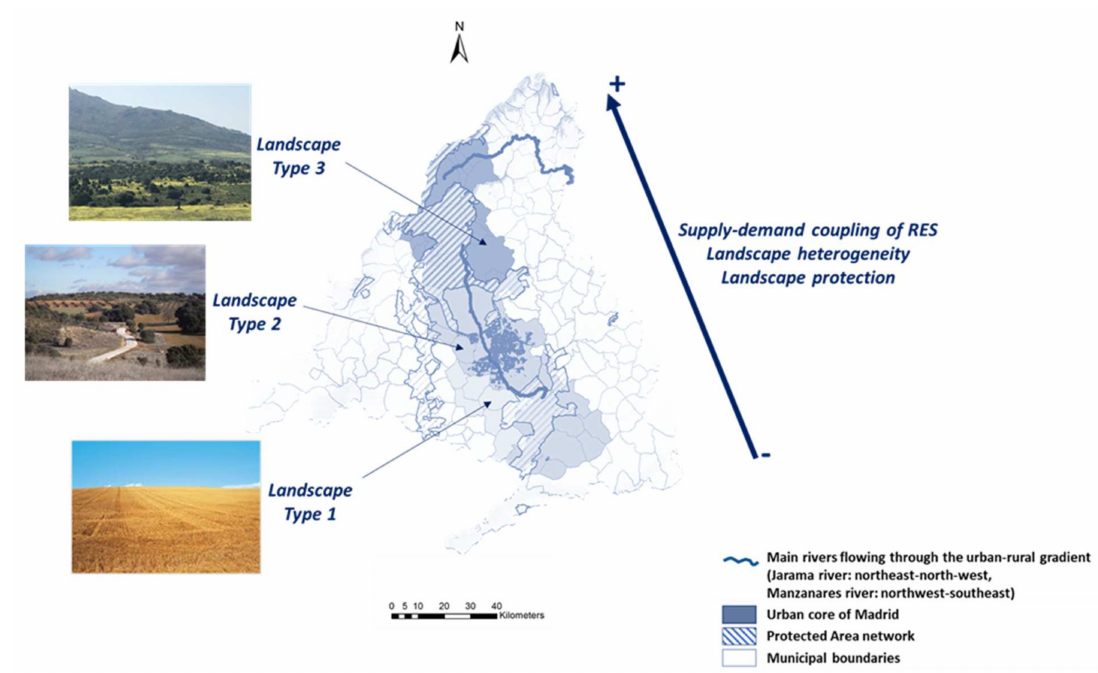
Figure 6. Schematic diagram summarizing the variation of the main social-ecological processes identified in the rural-urban gradient studied in the Madrid Region. The coupling between supply and demand for outdoor recreation and nature-based tourism is related to landscape heterogeneity and landscape